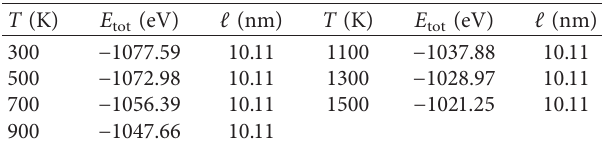
Figure 6: Common neighbors of FCC (a), HCP (b), and Amor (c) structures at different temperatures. Table 6: Energy and size of amorphous aluminium at different